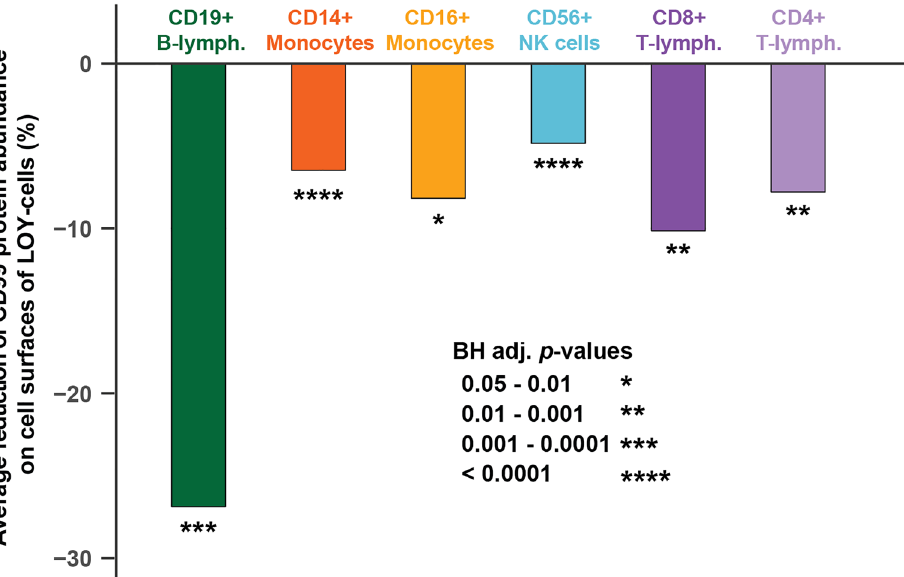
Figure 3. Reduced abundance of CD99 protein on the surface of LOY cells by cell type. The Y-axis display the average decrease in protein level observed in single cells with LOY compared with normal cells and expressed as percentage change. The percentage of change was calculated by transformation of the average log fold change estimated by Seurat , to improve interpretation. Asterisks denote adjusted significance levels after Benjamini- Hochberg (BH) correction for multiple testing.